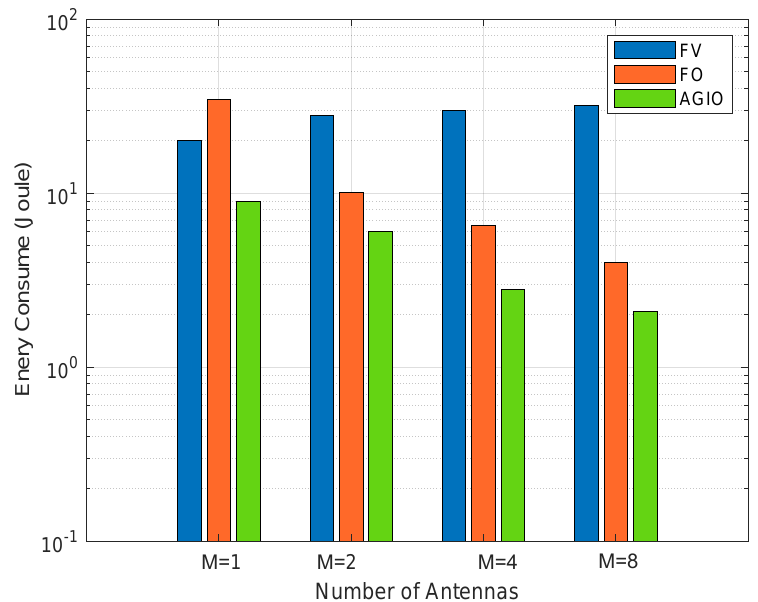
Figure 3. Comparison of energy consumption with a different number of antennas.